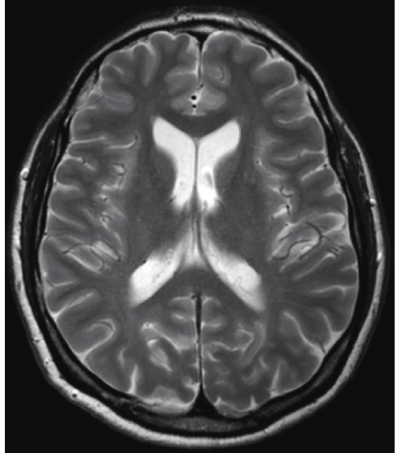
Figure 6: Axial T2-weighted brain MRI 2 months later shows complete resolution of the occipital